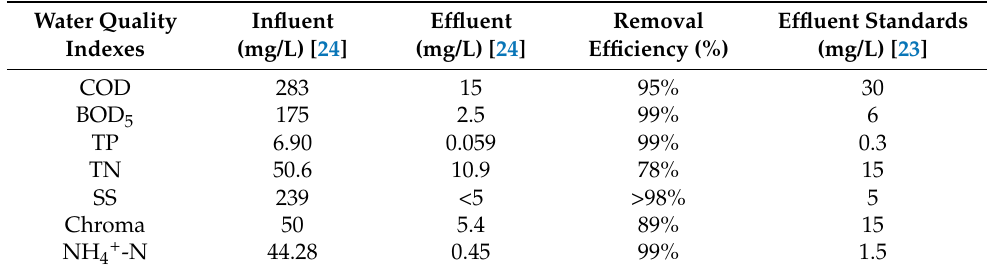
Table 1. Qualities of the influent and effluent in Gaobeidian